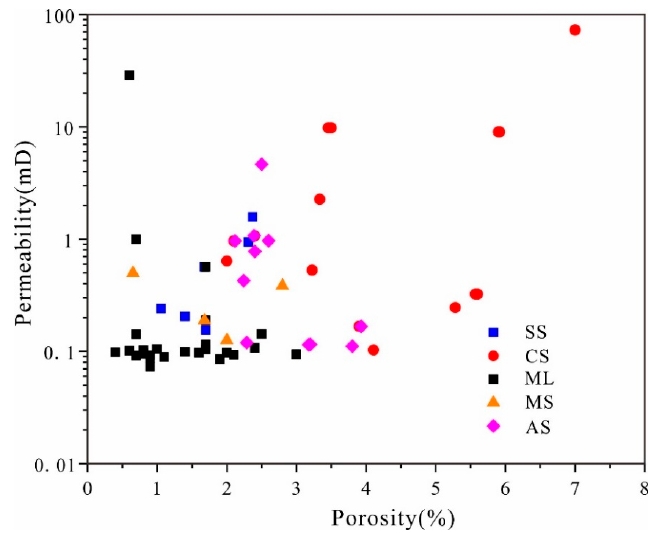
Figure 5. The relationship between porosity and permeability of 62 core samples. These samples were classified based on lithofacies. Note: SS: silty shale; CS: calcareous shale; ML: marl; AS: argillaceous shale; MS: muddy siltstone.